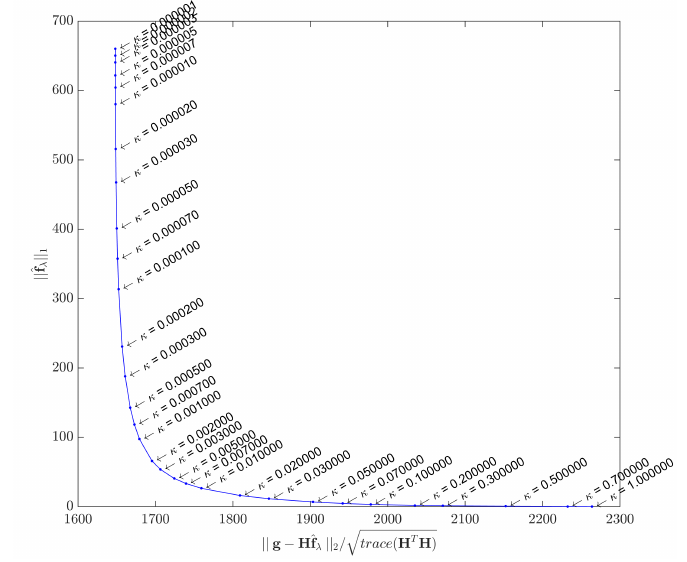
Figure 6. L-curve by IRLS method - Real dataset. Parameter κ ranges from 10 − 6 to 1. The curvature region is approximately delimited by κ = 5 × 10 − 4 and κ = 3 × 10 − 2